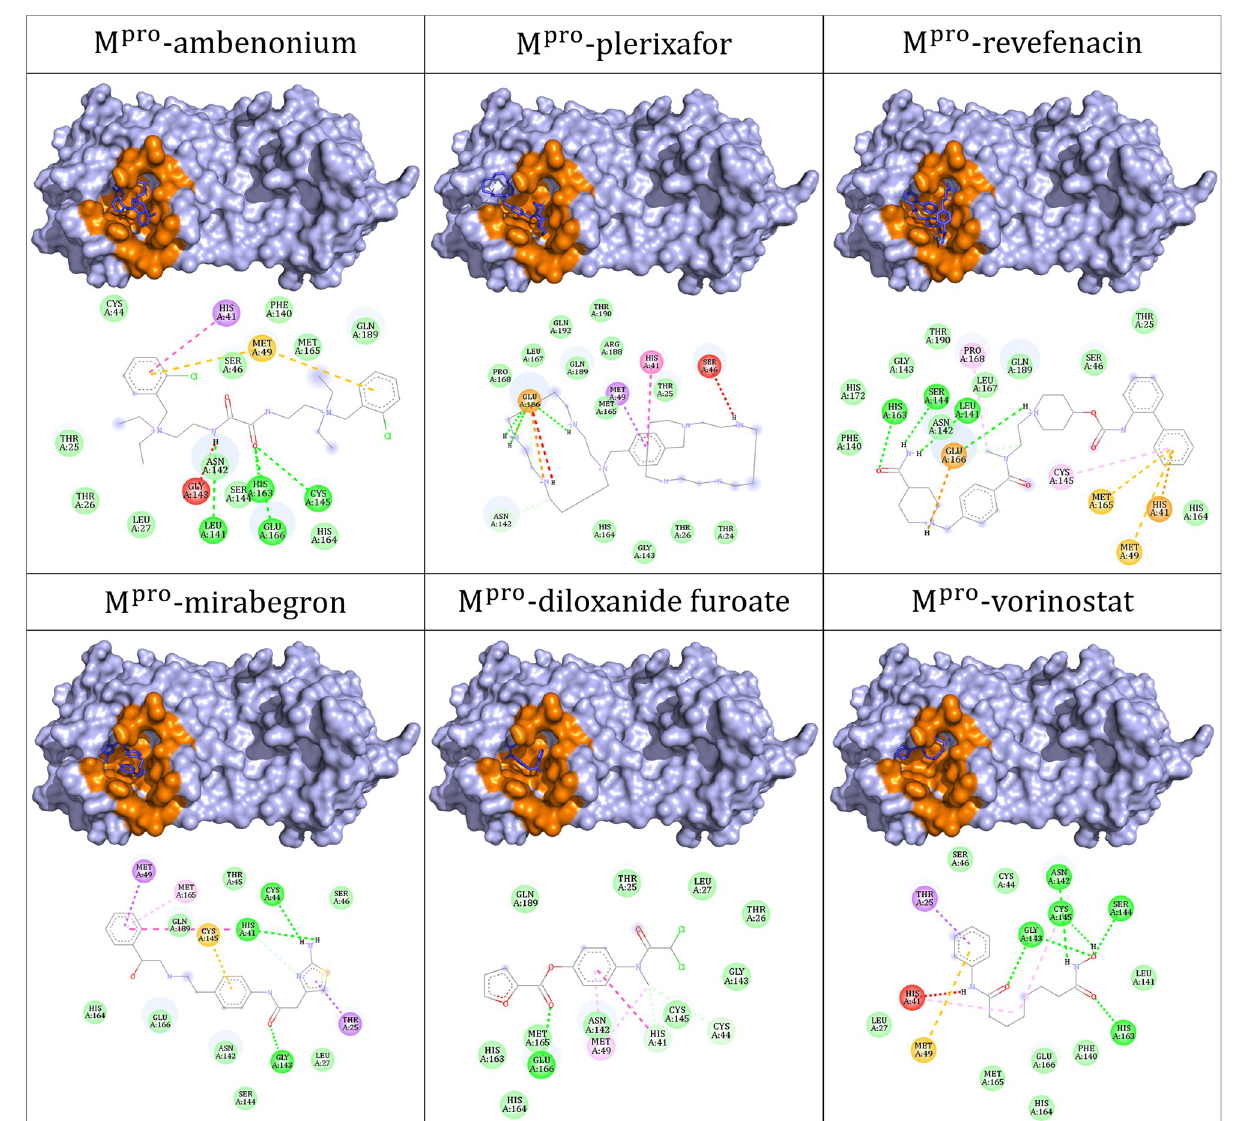
Fig 3. Top-scored complexes calculated by Autodock vina. The ligands (in blue) are well fitted in the M pro active site (in orange). Hydrogen bonds are represented by green dashed lines; attractive electrostatic interactions, as orange dashed lines; orbital π interactions, as pink, yellow and purple dashed lines; unfavorable interactions, as red. Residues involved in hydrophobic interactions are represented by light green circles.